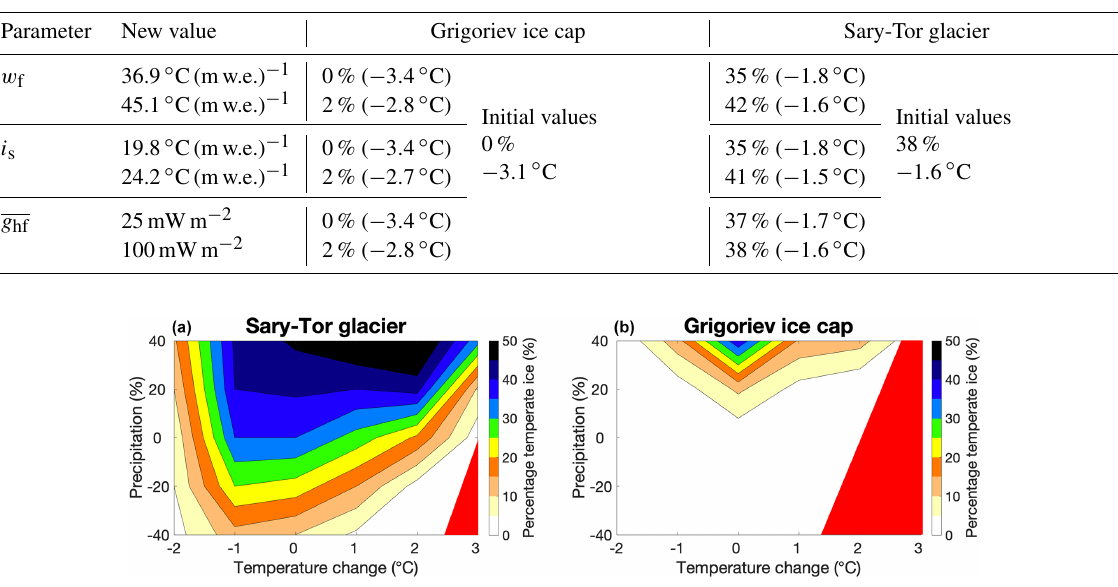
Table 4. Change in percentage of temperate ice and average temperature of both ice masses based on parameter changes of ± 10% for the firn warming ( w f ) and the snow insulation ( i s ) and 50% vs. 200% of the average geothermal heat flux ( g hf ). The values for the initial parameter values are also given.